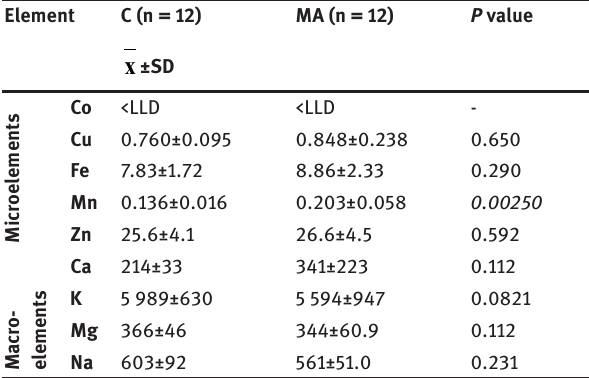
Table 8: The effect of enriched macroalgae on the average content of elements in meat of examined pigs (mg kg -1